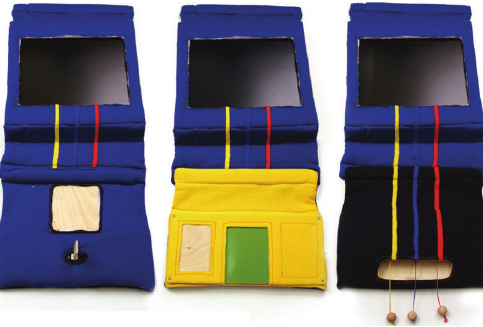
Figure 4: The KLEEd prototypes in di ff erent